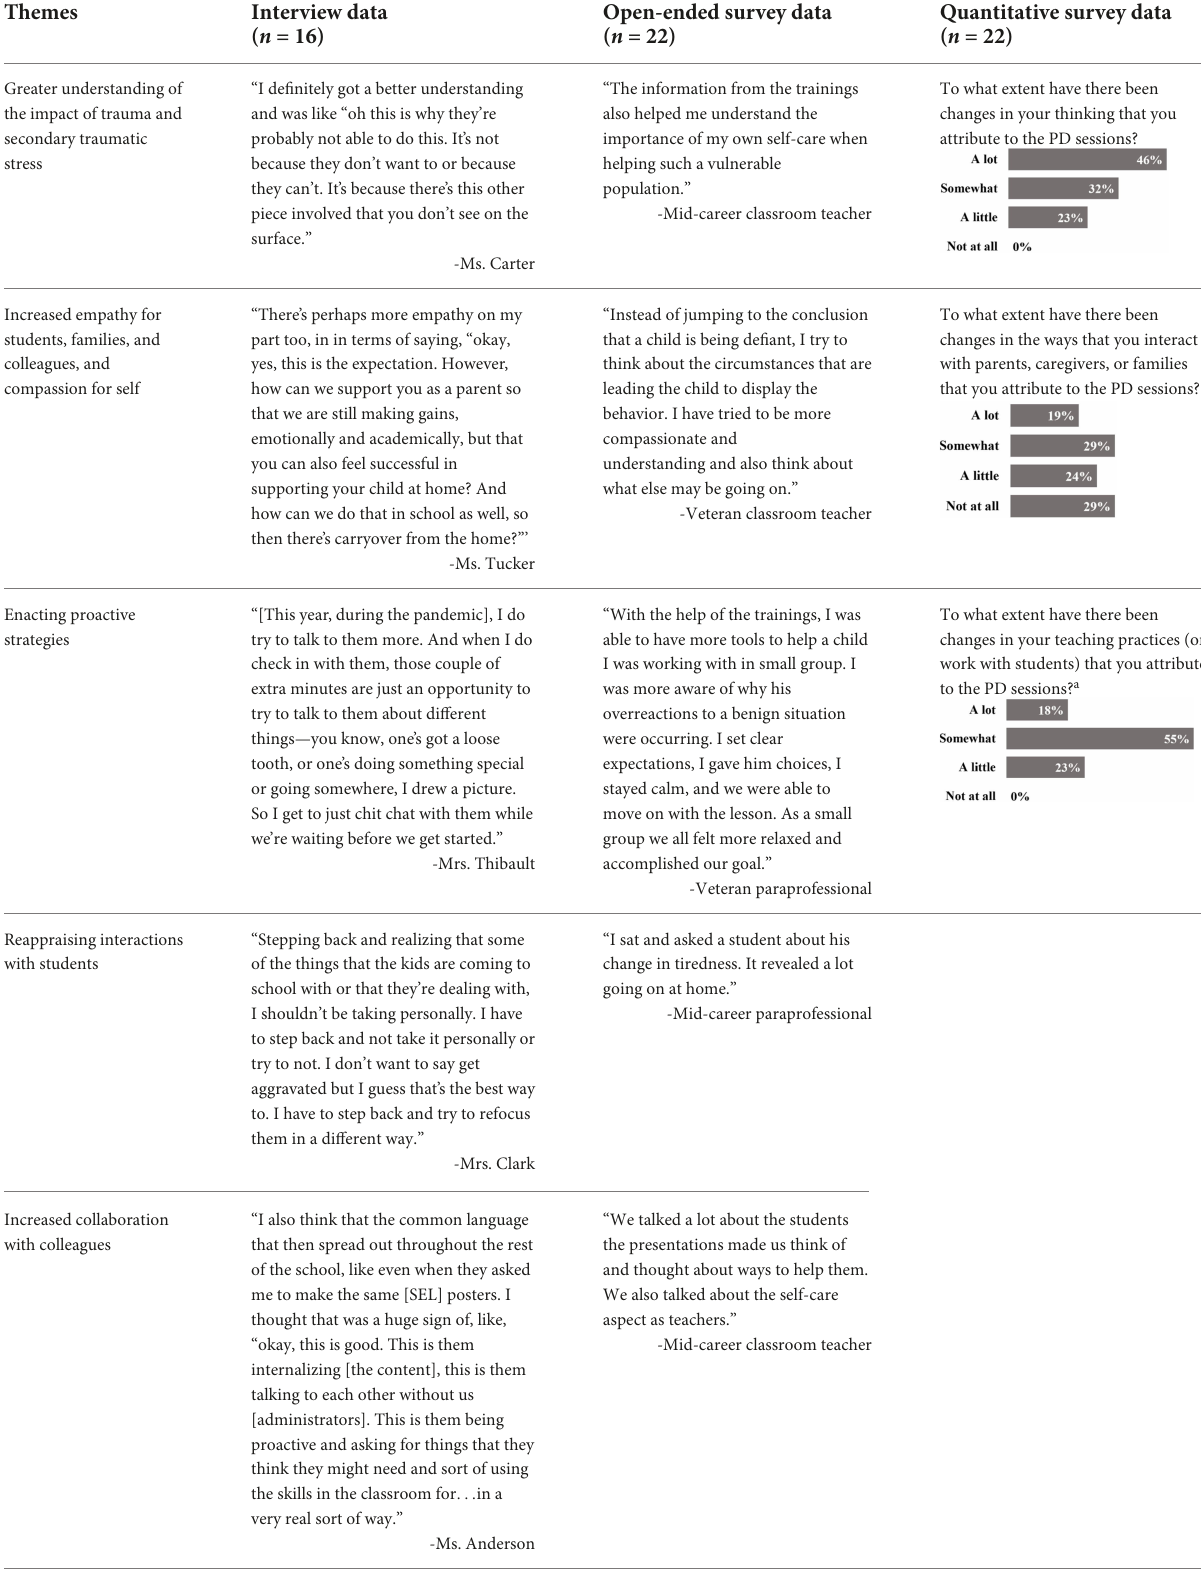
TABLE 4 Illustrative qualitative quotes and quantitative data in support of identified